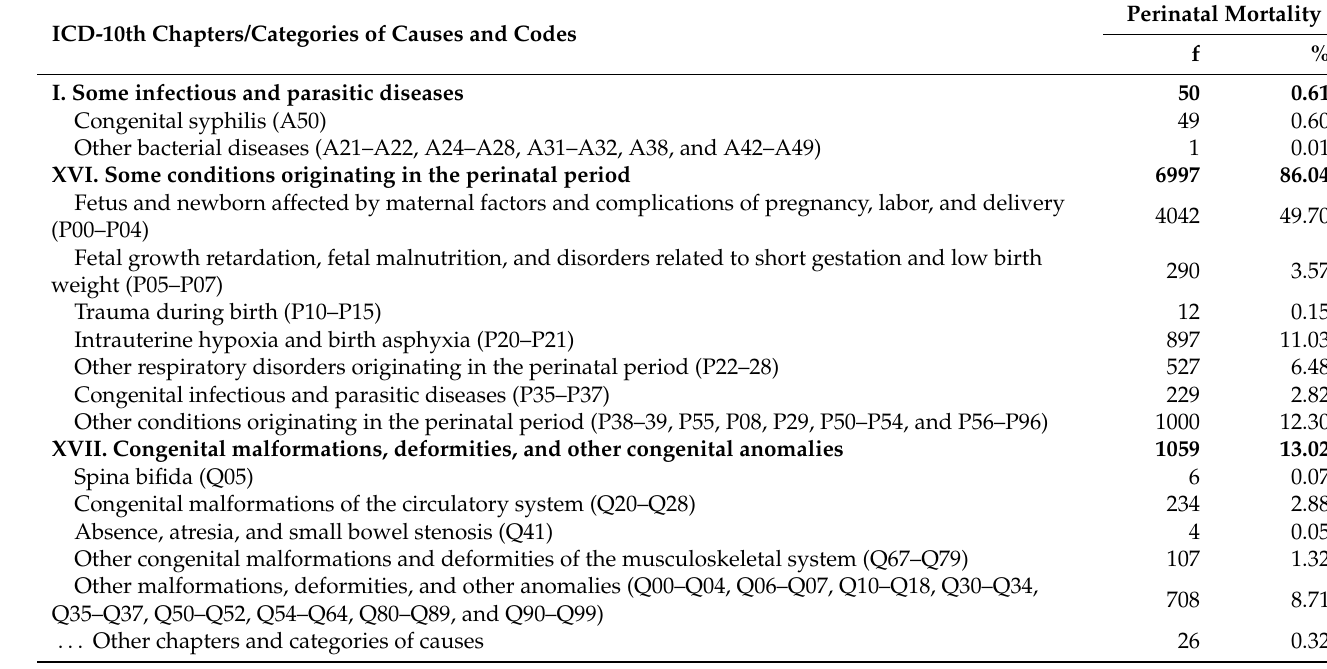
Table 5. Perinatal deaths by ICD-10 classification. Esp í rito Santo, Brazil,